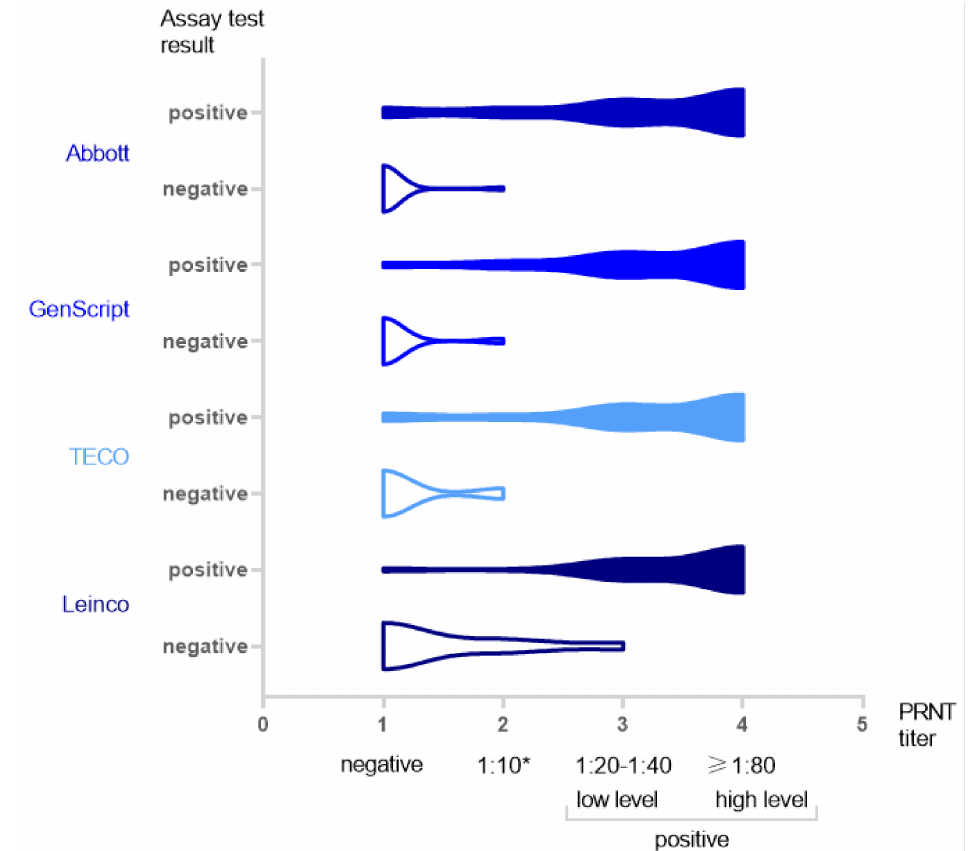
Figure 2. Distribution of test results of the examined SARS-CoV-2 antibody assays in relation to the PRNT results. The width of each violin reflects the number of generated results: wide = high number of results, narrow = low number of results; * “borderline” result.